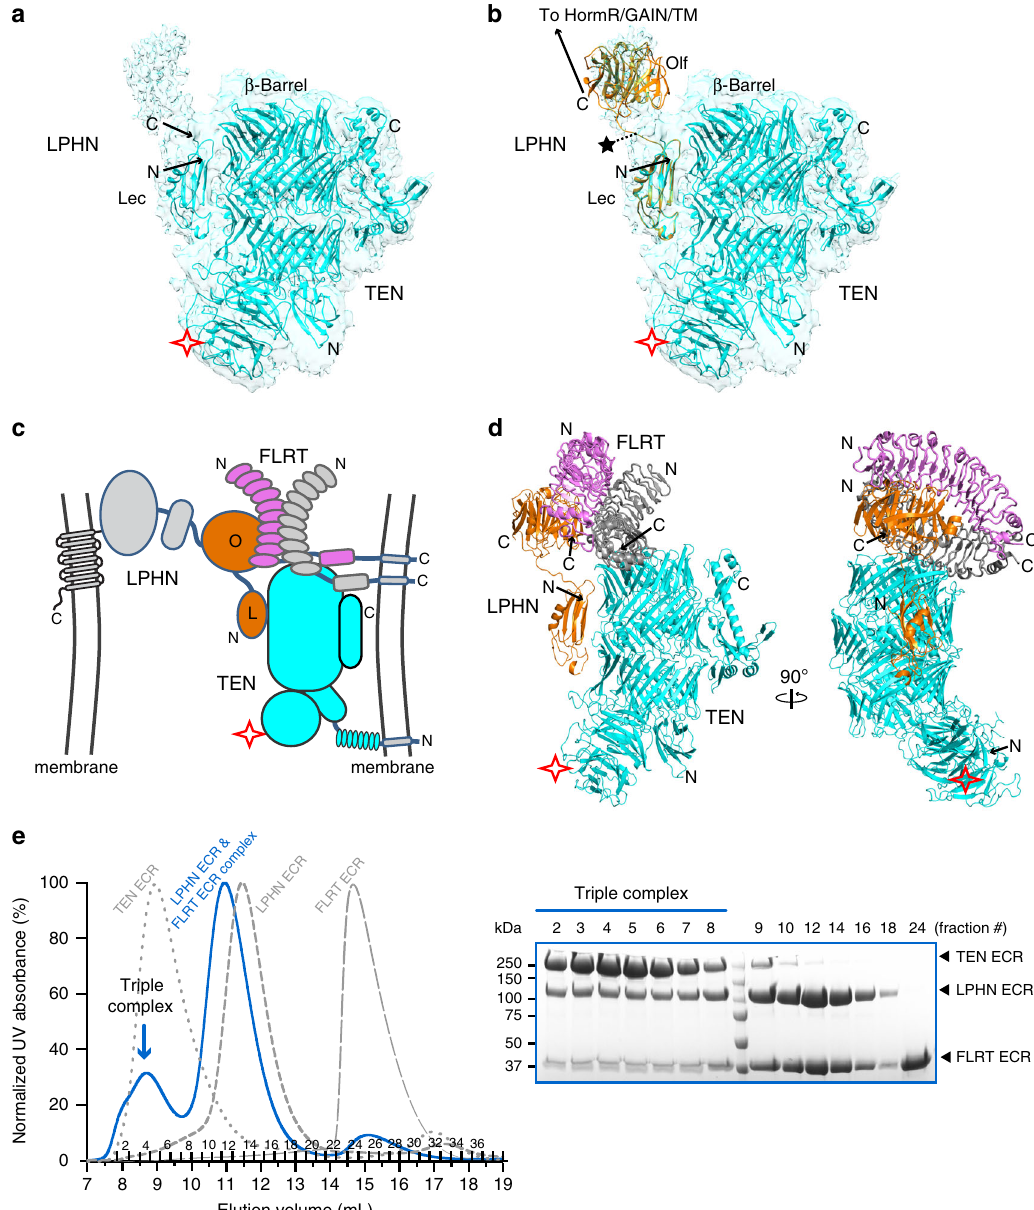
Fig. 2 LPHN3 interacts with TEN2 and FLRT3 simultaneously. a Continuous density C-terminal to the Lec domain of LPHN3 revealed by analysis of the cryo-EM maps at a lower threshold. b Manual fi tting of the Olf domain from the LPHN3 Lec – Olf structure (PDB: 5AFB) into the extra EM density. Ribbon diagram of TEN2/LPHN3-Lec complex is colored cyan and the LPHN3 Lec – Olf domains are colored orange. Lec domains are superimposed. c Schematic diagram of the trans-cellular positioning of the TEN2/LPHN3 complex; and the formation of a ternary complex between TEN2, LPHN3, and FLRT3. d Superimposition of the TEN2/LPHN3-Lec – Olf complex with the LPHN3/FLRT3 complex structure (PDB: 5CMN). The Olf domains are superimposed. TEN2 and LPHN3 are colored cyan and orange, respectively. FLRT3 molecules in the FLRT3 dimer are colored magenta and gray. The second LPHN3 molecule that might be bound to the FLRT3 dimer is not shown. An UNC5 molecule that might be bound to the magenta FLRT3 is not shown. e SD200 size-exclusion chromatography pro fi le of the TEN2/LPHN3/FLRT3 complex (Blue line) as compared to the pro fi les of individual proteins (dashed gray lines) showing that LPHN3 binds to TEN2 and FLRT3, simultaneously. Size-exclusion fractions are run on an SDS-PAGE gel. Triple complex is indicated by blue arrow. Source data are provided as a Source Data fi